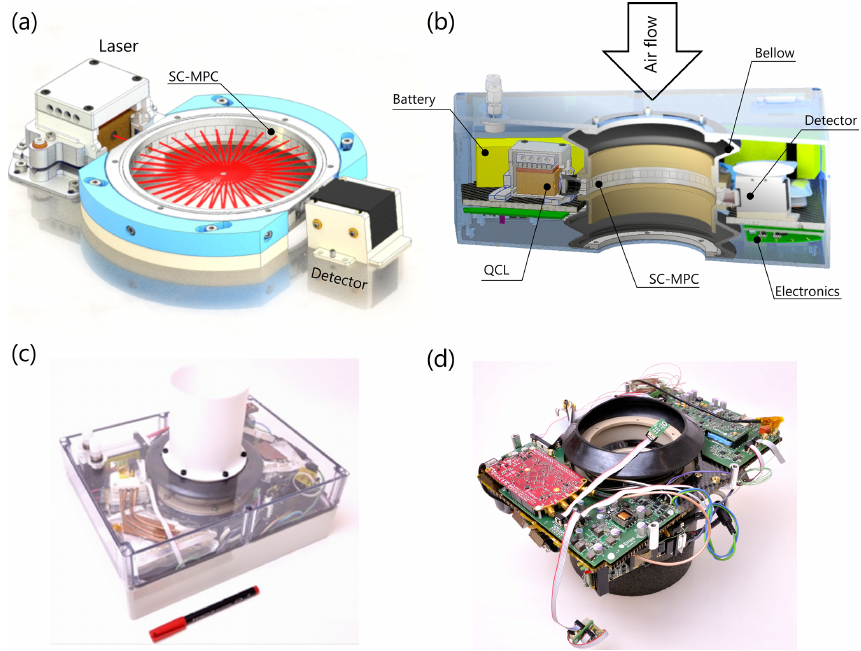
Figure 3. (a) Highly compact optical layout using the segmented circular MPC (SC-MPC), which enables the mounting of laser and detector very close to its coupling apertures. The beam reflection pattern is schematically depicted by the red trace. (b) Virtual cut showing the integration of our optical concept within the fully assembled spectrometer in open-path configuration. (c) Photo of the fully assembled spectrometer without insulation. (d) Photo of the driving and data acquisition electronics mounted below the optical